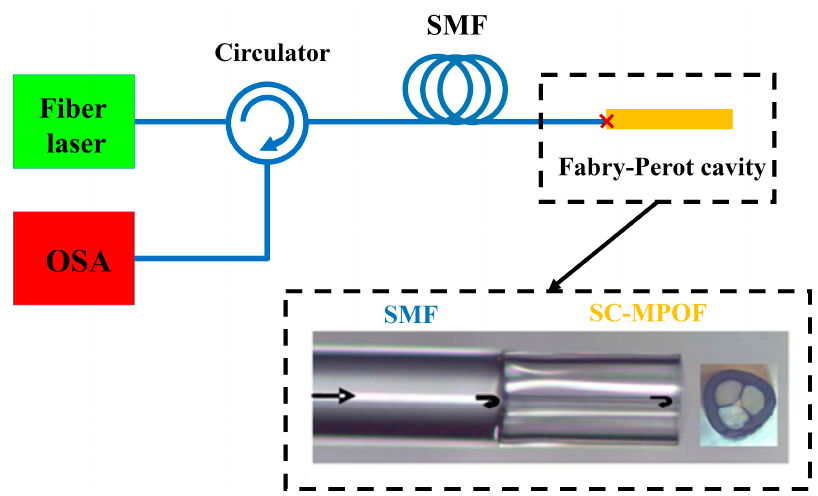
Figure 14. Schematic of experimental setup used for temperature based on Fabry-Perot system using single mode fiber (SMF) spliced with SC-MOF.